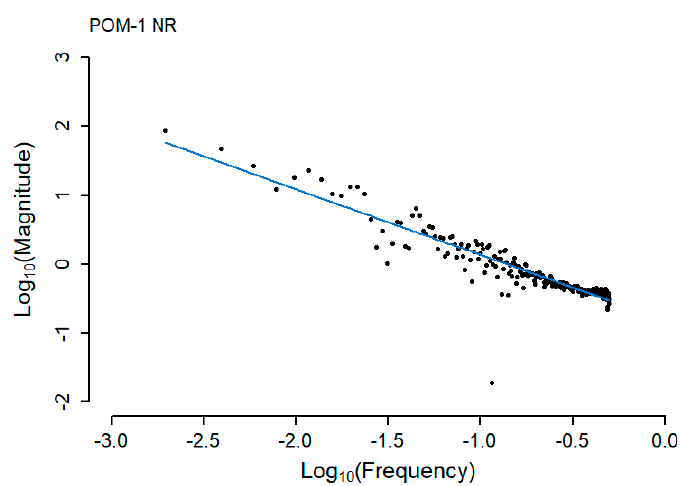
Figure 5. Linear curve fitted to the log 10 transformations of the FFT analysis outputs for point-operating machine POM-1 in the NR direction.